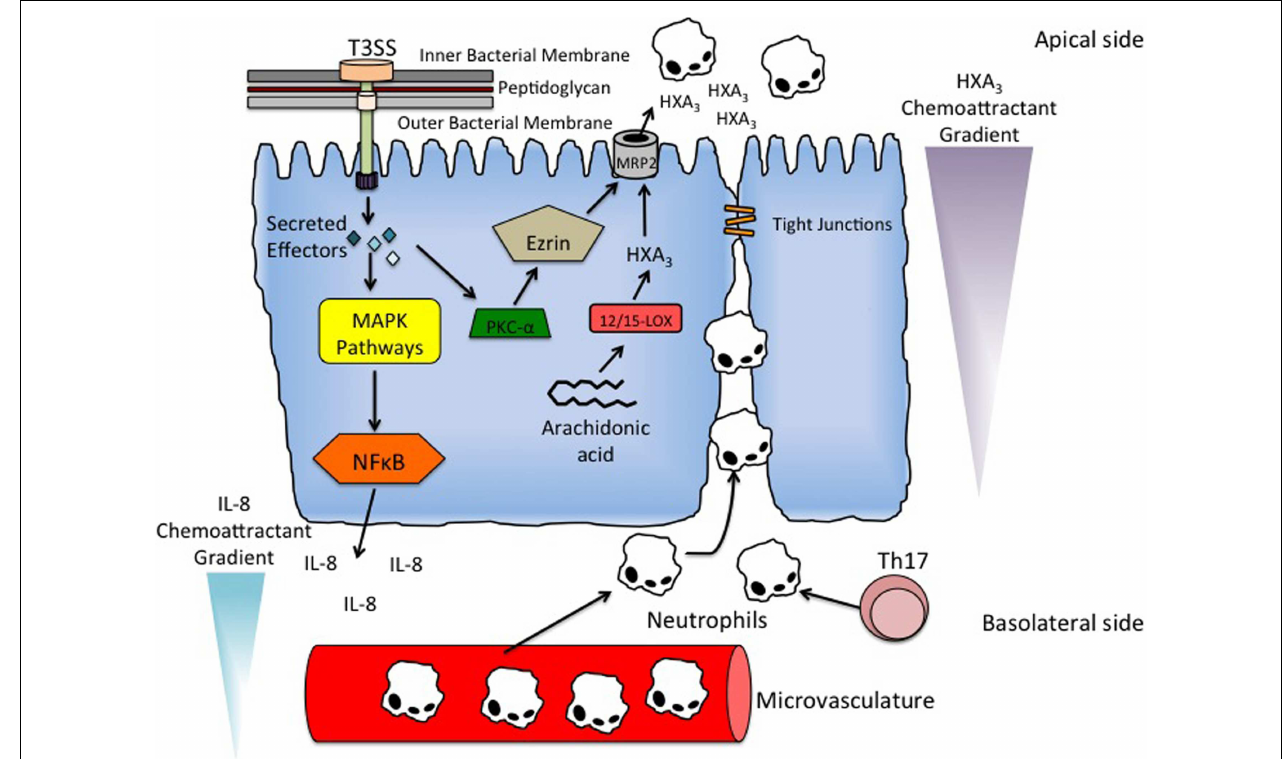
FIGURE 2 | Mechanism of PMN recruitment and PMN transmigration . S. typhimurium utilizes itsT3SS to secrete effector proteins into epithelial cells to activate inflammatory signaling pathways. In particular, the activation of Rho-GTPases by SopE, SopE2, and SopB result in the induction of mitogen-activated protein kinase (MAPK) pathways.The stimulated pathways include ERK, JNK, and p38, resulting in the terminal activation of major inflammatory regulator NF- κ B. Activation of NF- κ B results in the basolateral secretion of IL-8 producing a chemoattractant gradient that recruits neutrophils to the subepithelial region from the underlying microvasculature.Th17 cells are also present in the subepithelial region,